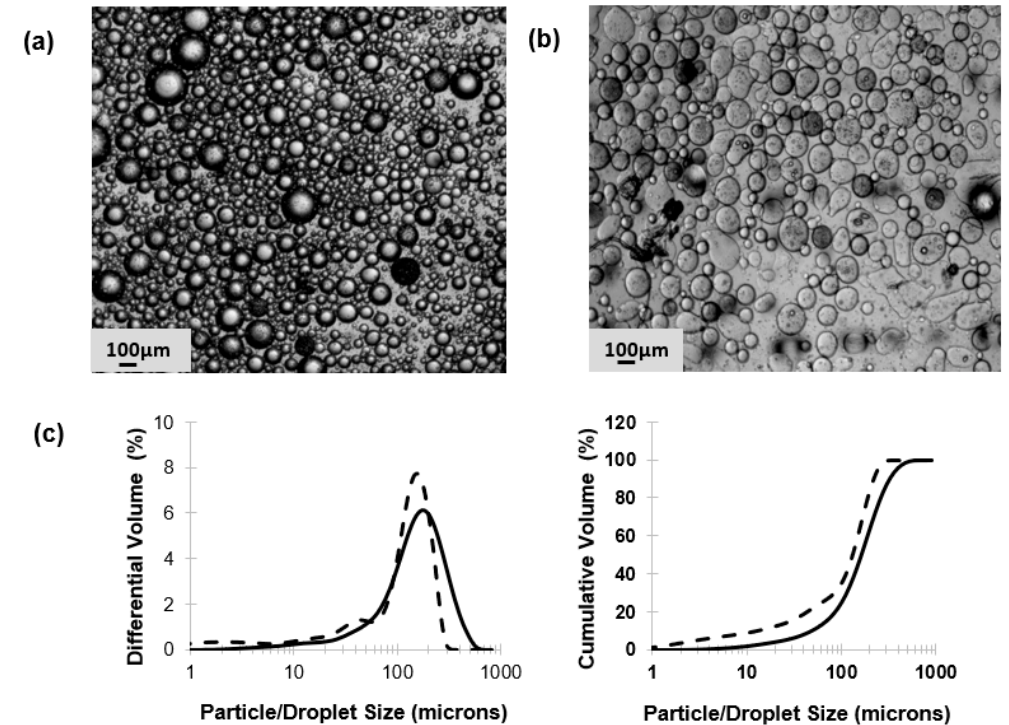
Figure 2. Optical images of water-in-oil (W / O) emulsion droplets, crosslinked microparticles, and size distribution of phage-containing emulsion droplets and microparticles: ( a ) water-in-oil emulsion, ( b ) microparticles produced from W / O emulsions following toluenesulfonic acid (TSA) and CaCl 2 crosslinking, and ( c ) droplet and particle size distributions (solid lines—droplets; dashed